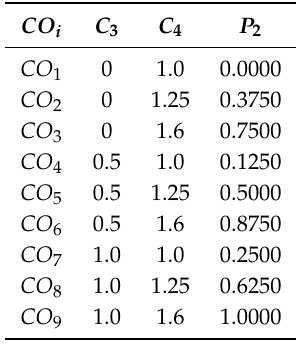
Figure 10. Visualization of triangular fuzzy numbers for Frag gaining assessment model ( P 2 ). Table 5. Overview of characteristic objects CO , vector P values for the Frag gaining assessment model.